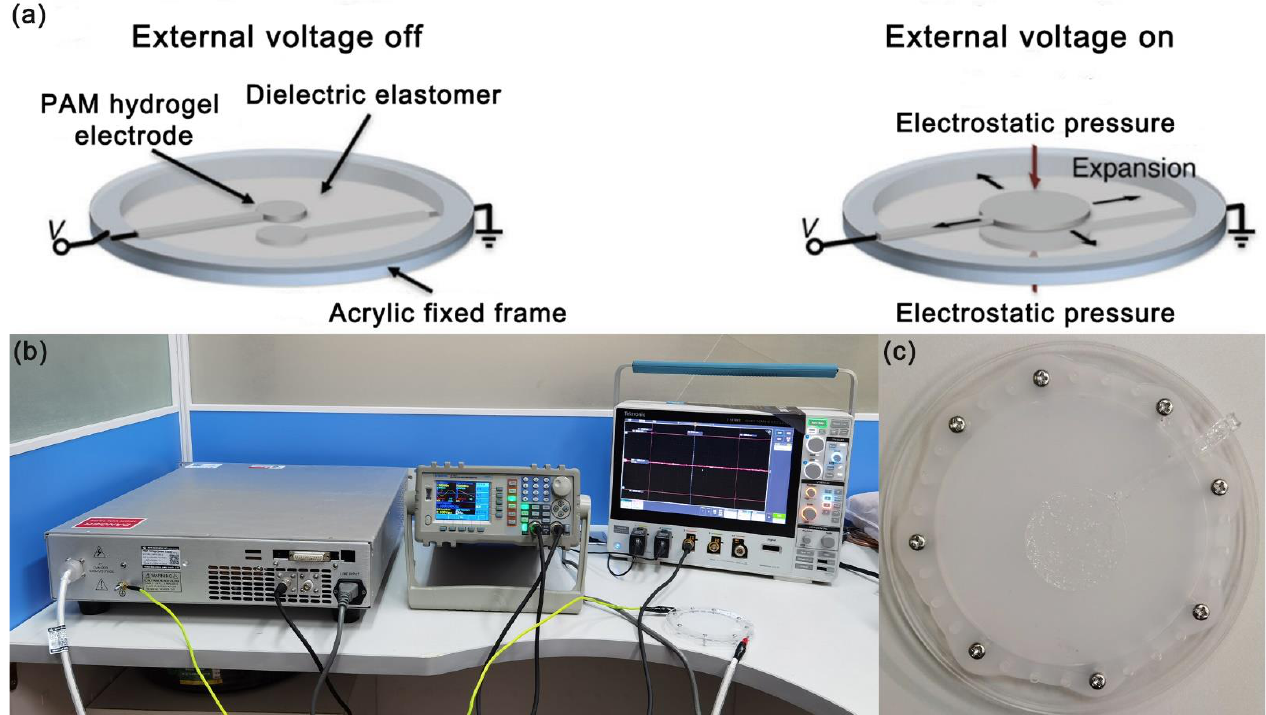
Figure 7. ( a ) Schematic diagram of actuating mechanism of flexible actuator based on PAM conductive hydrogel electrodes; ( b ) the whole experimental device for the verification experiment of the actuating mechanism of the flexible actuator; ( c ) upper view of flexible actuator based on PAM conductive hydrogel electrodes.